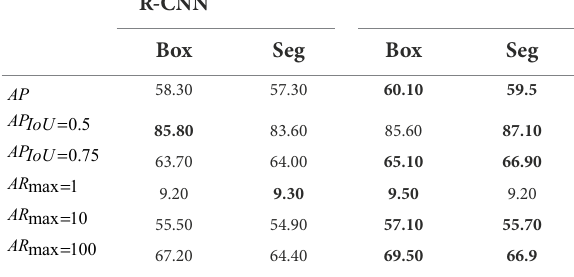
TABLE 7 Comparative test results of the improved Mask R-CNN model against Faster R-CNN and SOLOv2.